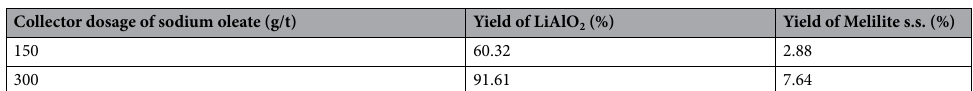
Collector dosage of sodium oleate (g/t) Yield of LiAlO 2 (%) Yield of Melilite s.s. (%) 150 60.32